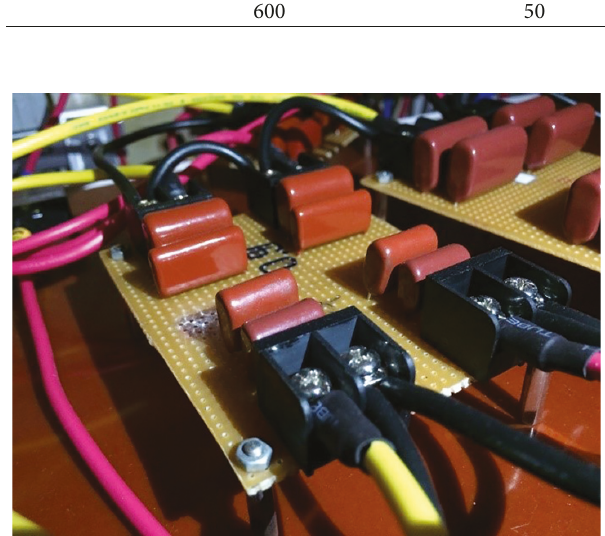
Figure 11: Capacitors of the HVDC transmission